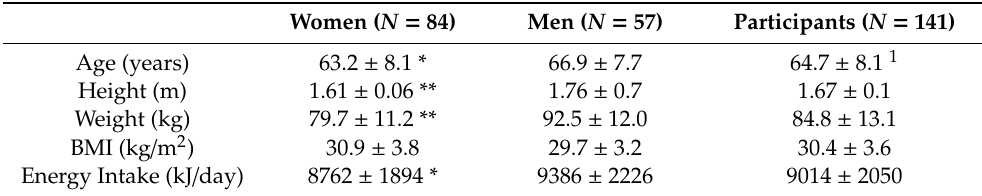
Table 2. Participant characteristics of 141 middle-aged to older Australian adults at baseline of a dietary intervention trial 1